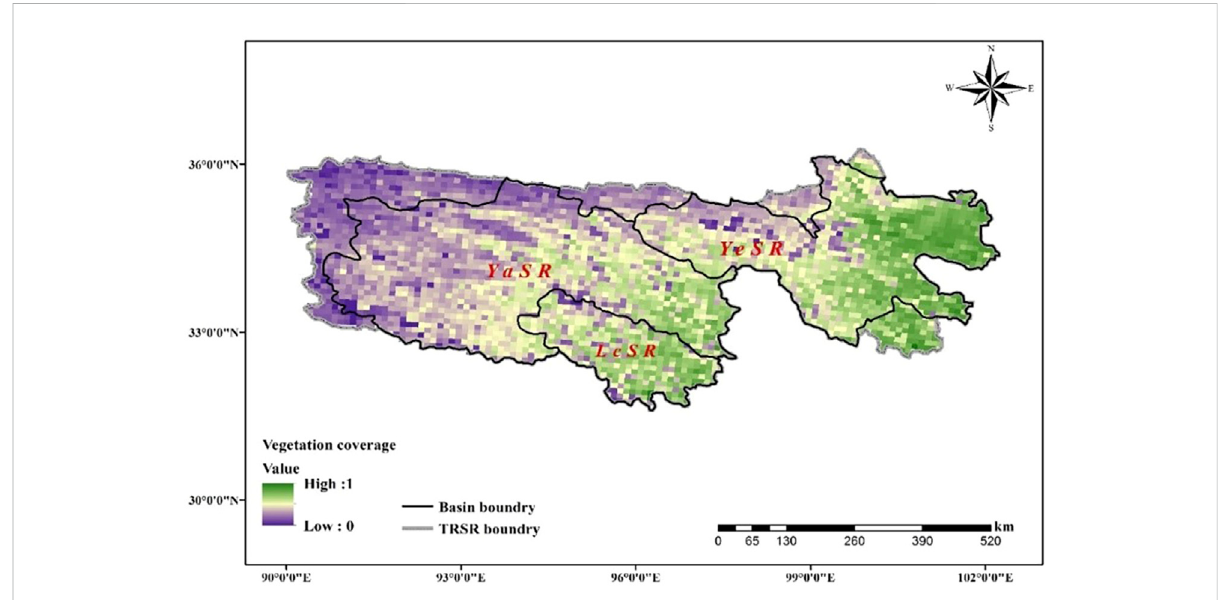
FIGURE 2 Spatial distribution of vegetation coverage in the TRSR of Tibetan Plateau, China.